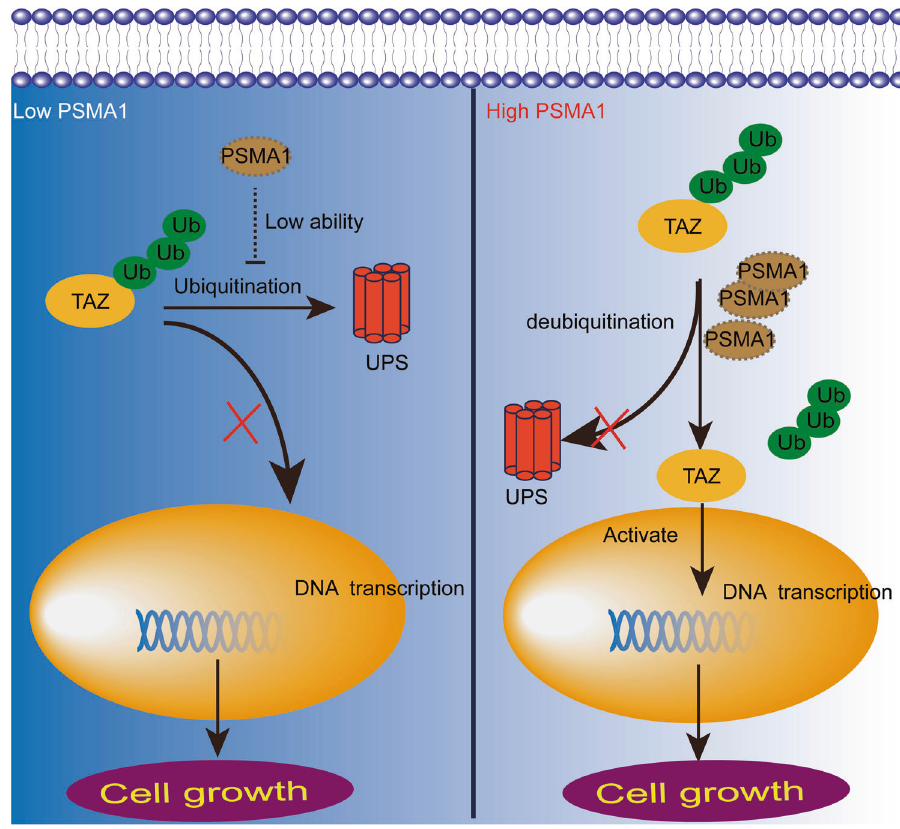
Fig. 8 Scheme for the regulatory mechanism of PSMA1 on